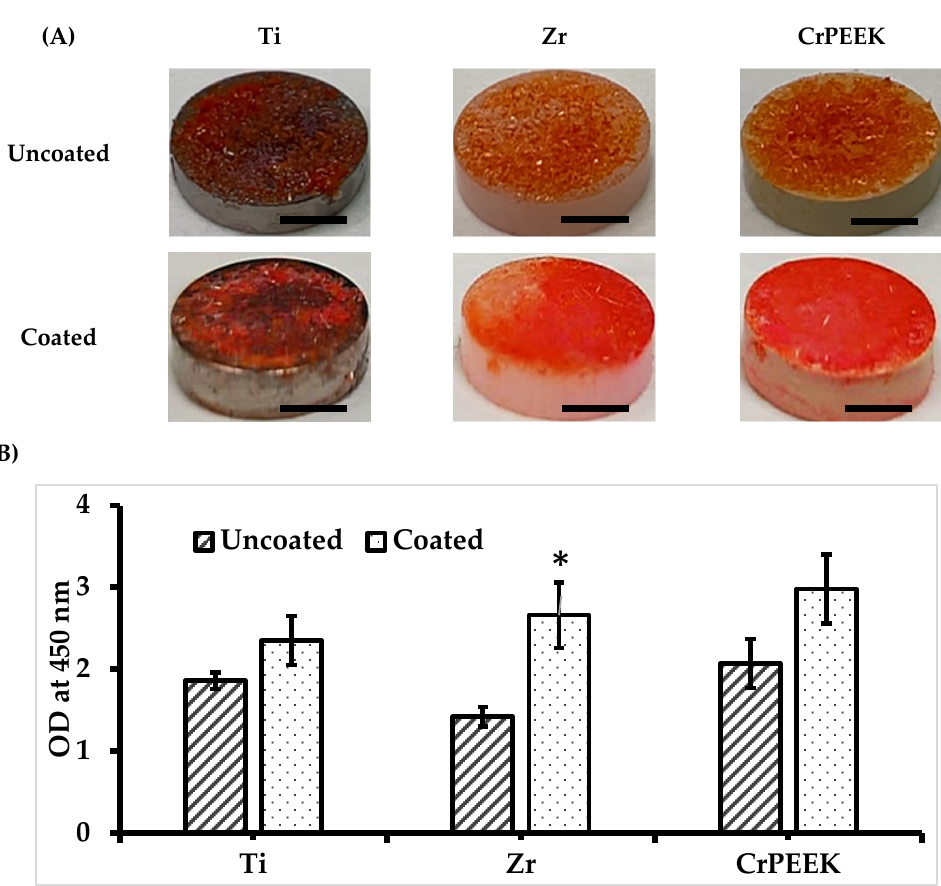
Figure 2. ( A ) Visualization of the apatite layer formed on each sample under Alizarin red stain. ( B ) Results obtained after quantitative analysis using the UV-Vis spectrometric method at 450 nm (SpectraMax iD3 Multi-Mode Microplate Reader). Ti—Titanium; Zr—zirconium; CrPEEK—ceramic-reinforced PEEK. Scale bar: 0.3 cm. Values are mean + standard deviation, and * denotes statistical significance, p < 0.05 vs. uncoated.